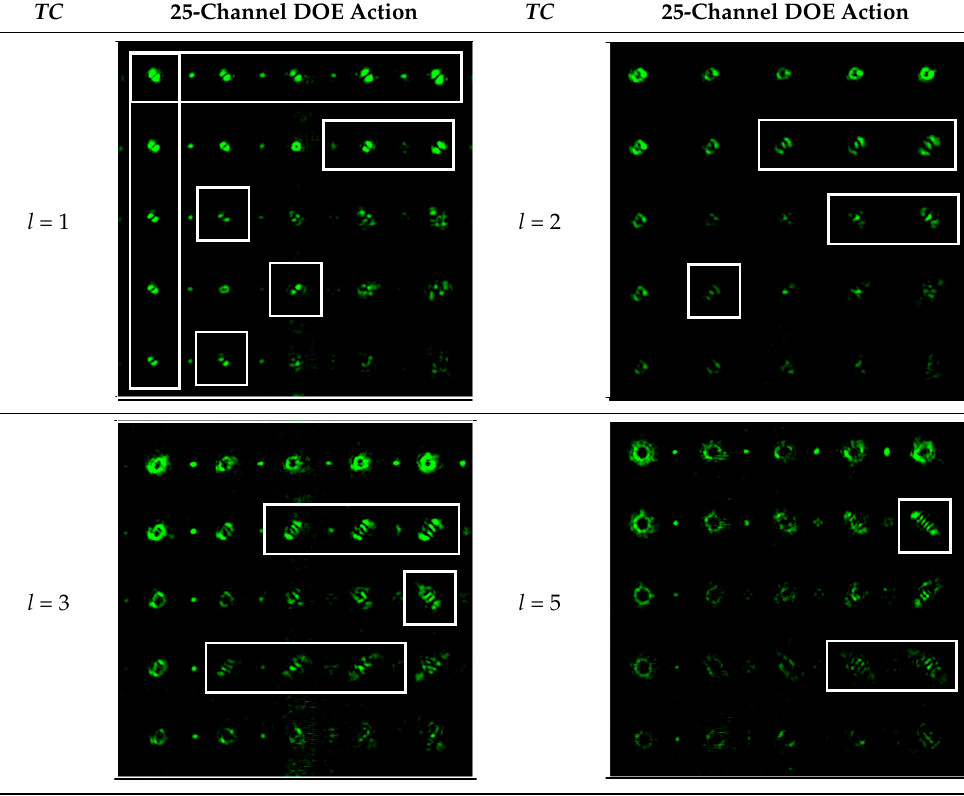
Figure 6. The experimentally registered intensity distribution for the Gaussian beam illumination of the multi-channel DOE matched with different astigmatic aberrations of type ( n , 2) of different levels of α from 0.1 λ to λ . Table 8. The experimental results for the 25-channel DOE when illuminated with a vortex beam with TC l = 1, 2, 3, 5 (diffractive orders with astigmatic intensity pictures convenient for TC recognition were marked with frames).